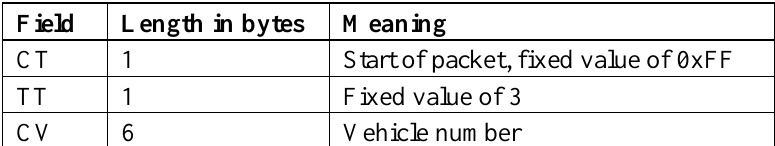
Table 6. Datagram T3.